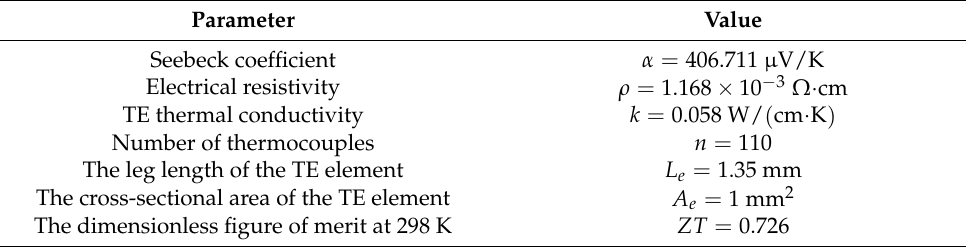
Table 3. Experimental module (TEC1-12706) effective material properties.